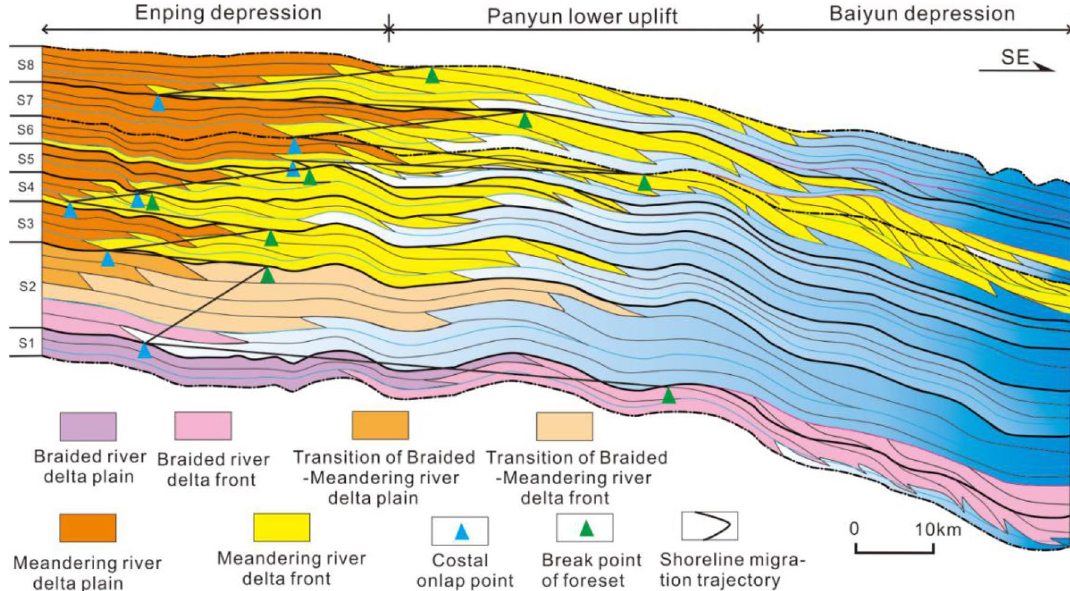
Figure 10. Depositional and evolution model of the braided and meandering river deltas in the Early-Mid Miocene on the northern Pearl River Mouth basin, based on the identification of deltaic deposits in the wells and cores. Tracking the costal onlap points and break points of the foreset on 3D seismic profiles can establish the shoreline migration trajectory, which can be compared to global sea level changes 51,52 .